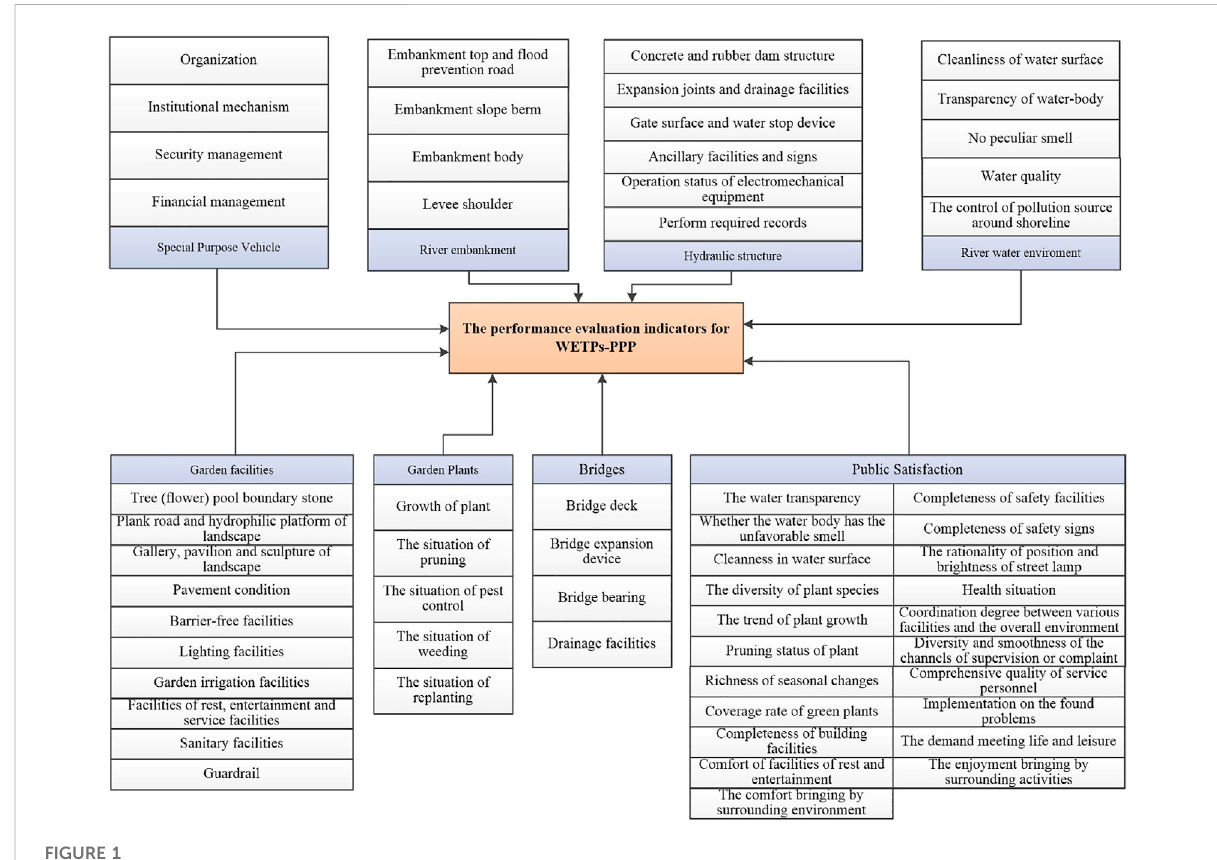
FIGURE 1 Performance monitoring indicators for